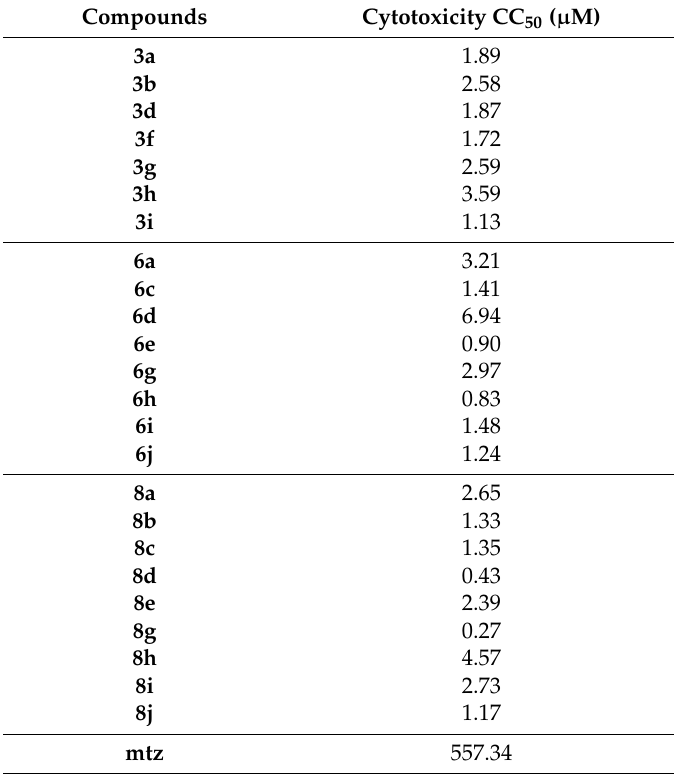
Table 11. Cytotoxicity evaluation on Chinese Hamster Ovary